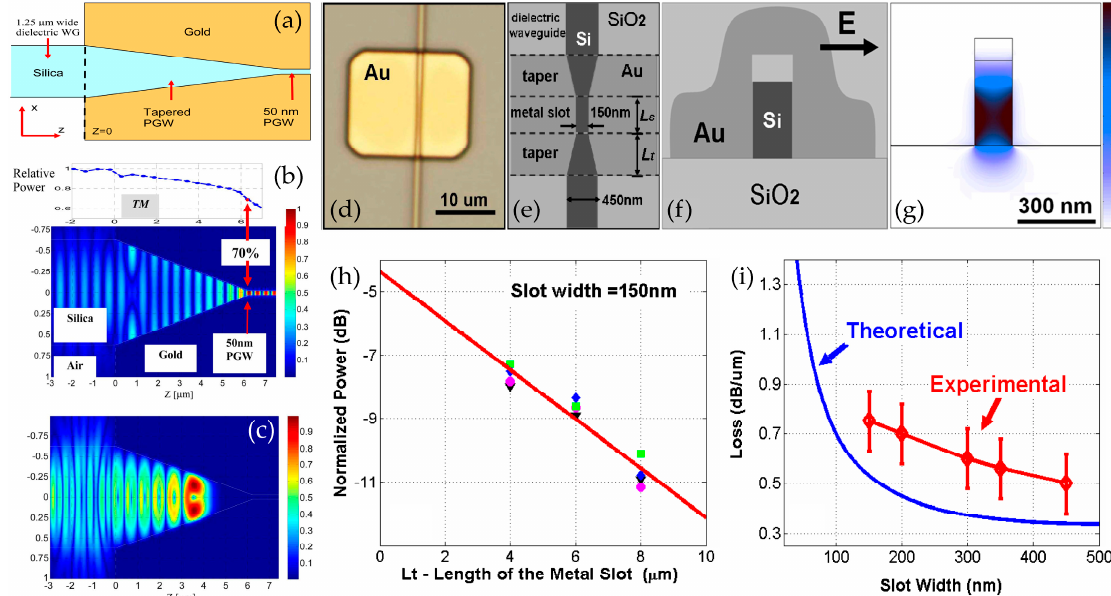
Figure 7. Tapered coupling design with reduction in width. Schematic configuration of the proposed taper for coupling a 1.25 μ m-wide dielectric strip waveguide with a 50 nm-wide metal slot waveguide ( a ) and its field profile ( b , c ) [119]. Microscope image ( d ), schematic structure ( e , f ), and field distribution ( g ) of the fabricated tapered coupler between a standard silicon strip waveguide and a metal slot waveguide. ( h , i ) The transmitted power as a function of the length of metal slot L t and the propagation losses as a function of the metal slot width, respectively [120]. The wavelength λ = 1550 nm. Figures reproduced from ( a – c ) [119]; ( d – i ) [120].